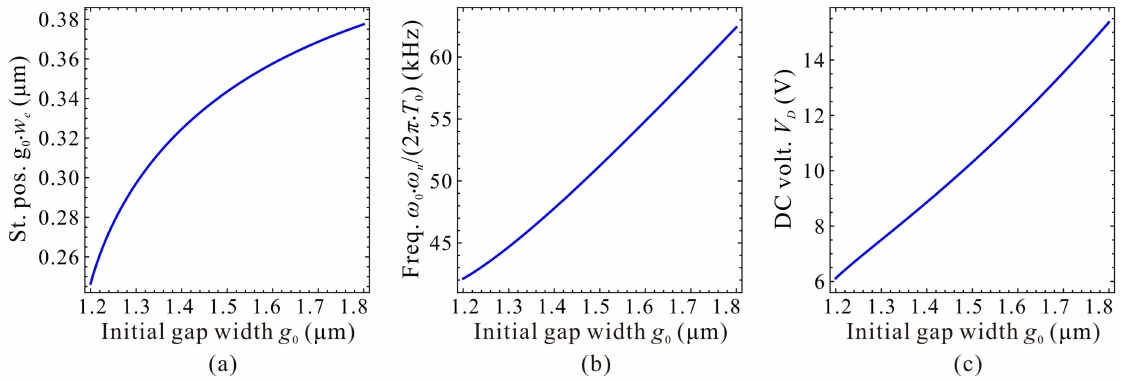
Figure 16. Qualitative property of the static position (St. pos.) ( a ), fundamental frequency (Freq.)